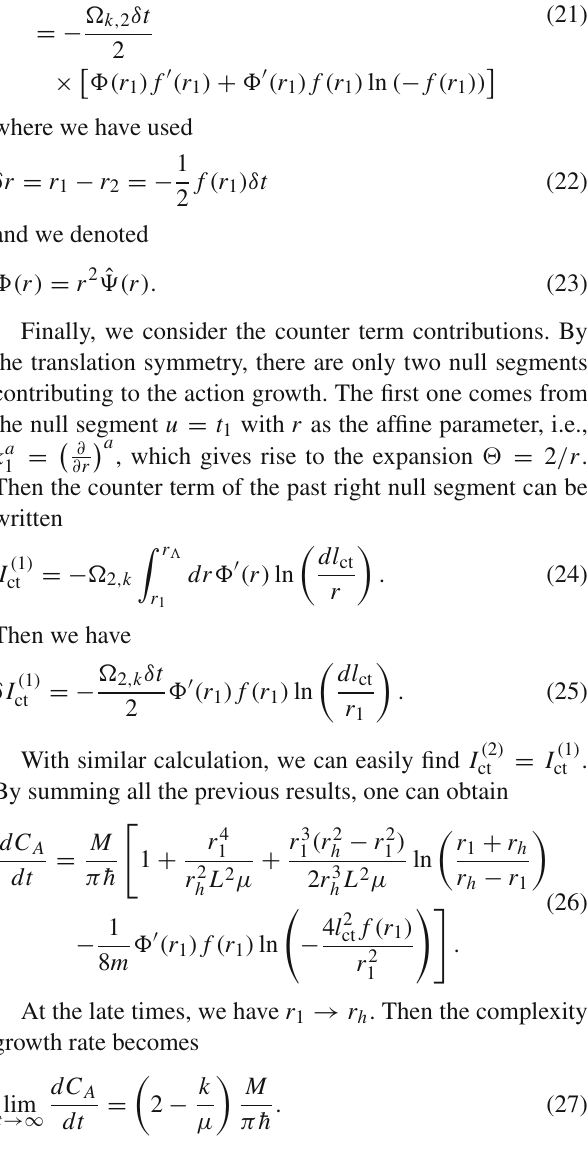
spherical case ( k = 1 ) , it is lower than the saturated value, while for the hyperbolic case ( k = − 1 ) , the late-time